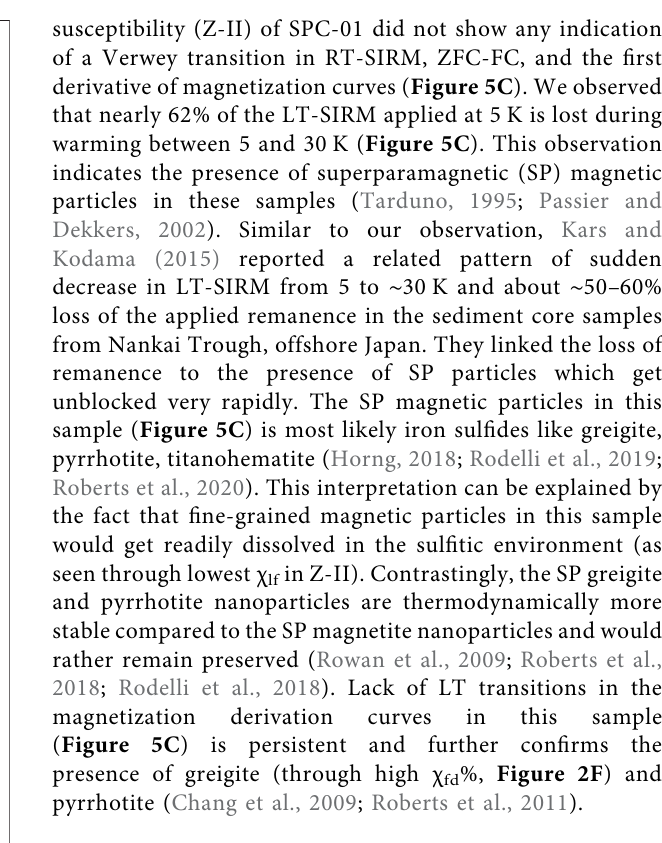
Frontiers in Earth Science |